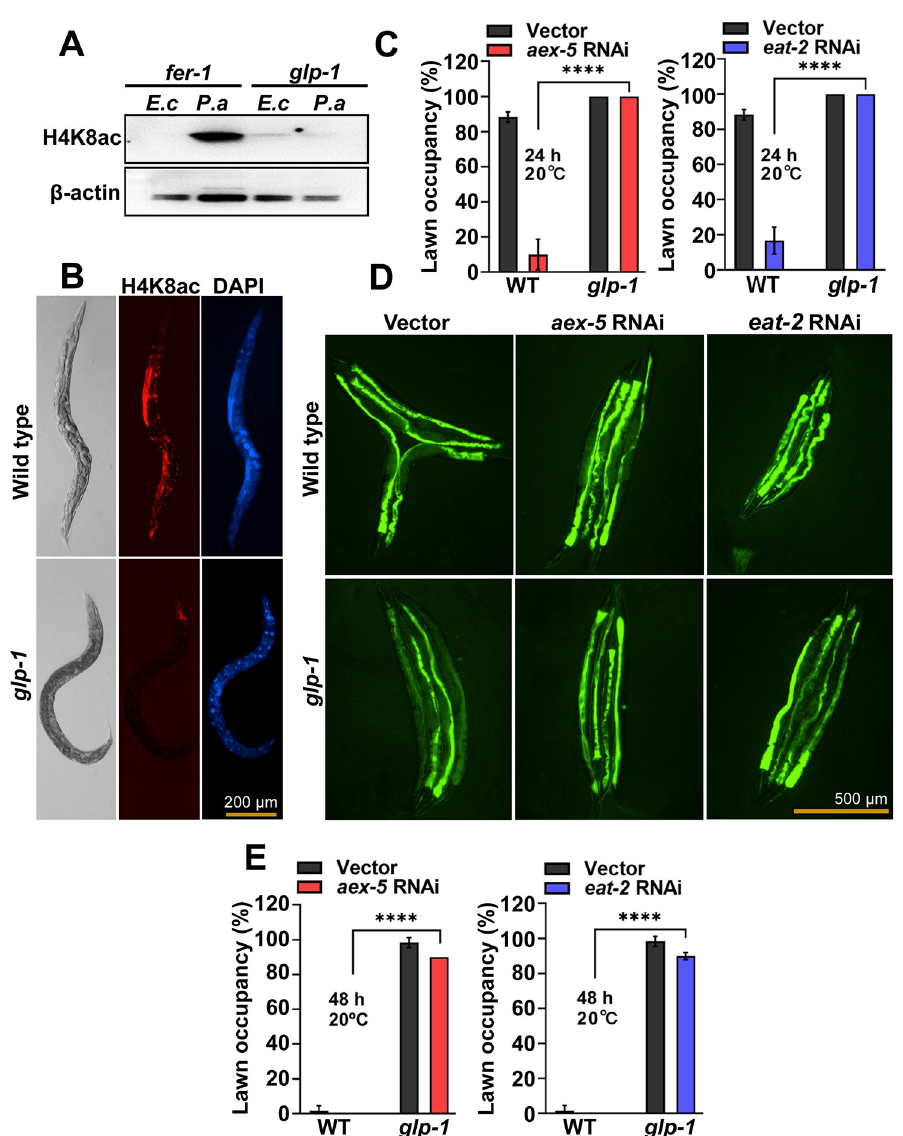
Fig 2. The germline is part of the gut-neural axis involved in pathogen avoidance. (A) Western blot of extracts from fer-1(b232) and glp-1(e2141) animals exposed to E . coli ( E . c ) or P . aeruginosa ( P . a ) for 24 hours at 25˚C ( n � 1,000; representative of 3 independent experiments). (B) Representative microscopic images of wild-type N2 and glp-1(e2141) animals stained with anti-H4K8ac antibody following exposure to P . aeruginosa for 24 hours at 25˚C. (C) Lawn occupancy of wild-type N2 (WT) or glp-1(e2141) animals at 24 hours of exposure to P . aeruginosa at 20˚C following aex-5 and eat-2 RNAi ( n = 20). Three independent experiments were performed. “n” represents the number of animals for each experiment. “ � ” asterisk indicates significant difference; ���� P � 0.0001. (D) Bacterial colonization of wild- type N2 and glp-1(e2141) animals after 48 hours of exposure to P . aeruginosa at 20˚C following aex-5 and eat-2 RNAi ( n = 4). (E) Lawn occupancy of wild-type N2 (WT) or glp-1(e2141) animals at 48 hours of exposure to P . aeruginosa at 20˚C following aex-5 and eat-2 RNAi ( n = 20). Three independent experiments were performed. “n” represents the number of animals for each experiment. “ � ” asterisk indicates significant difference; ���� P � 0.0001. The fer-1(b232) and glp-1(e2141) animals were maintained at 15˚C. To induce sterility, L1-stage animals were transferred to 25˚C and allowed to develop into young adults and subjected to the corresponding assays. For RNAi induction, L4-stage animals were transferred to RNAi plates and allowed to grow for 24 hours at 25˚C. See S1 Raw Images for uncropped immunoblot images and S1 Data for the corresponding data. H4K8ac, histone H4 Lys8 acetylation; RNAi, RNA interference; WT, wild